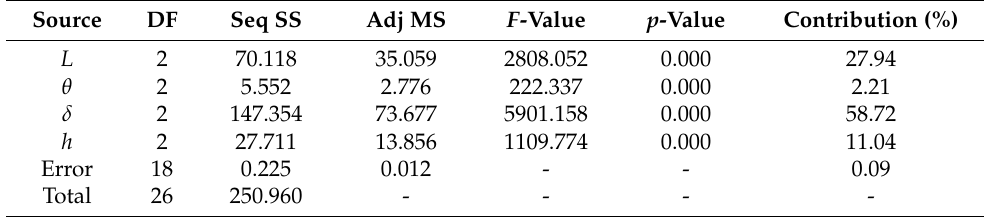
Table 2. ANOVA for stiffness.